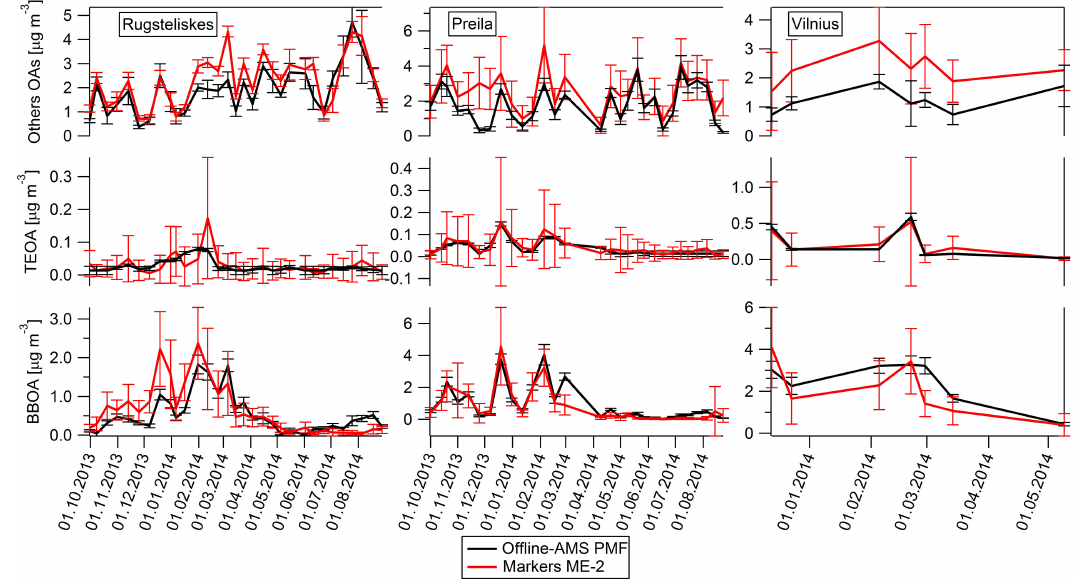
Figure 6. Marker-PMF and offline-AMS OM source apportionment